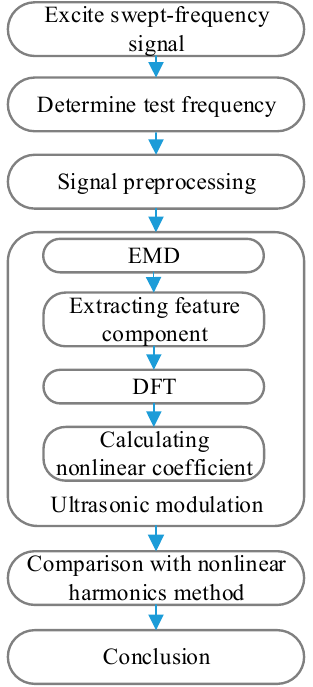
Figure 2. The debonding evaluation process of the hidden frame supported glass curtain wall.